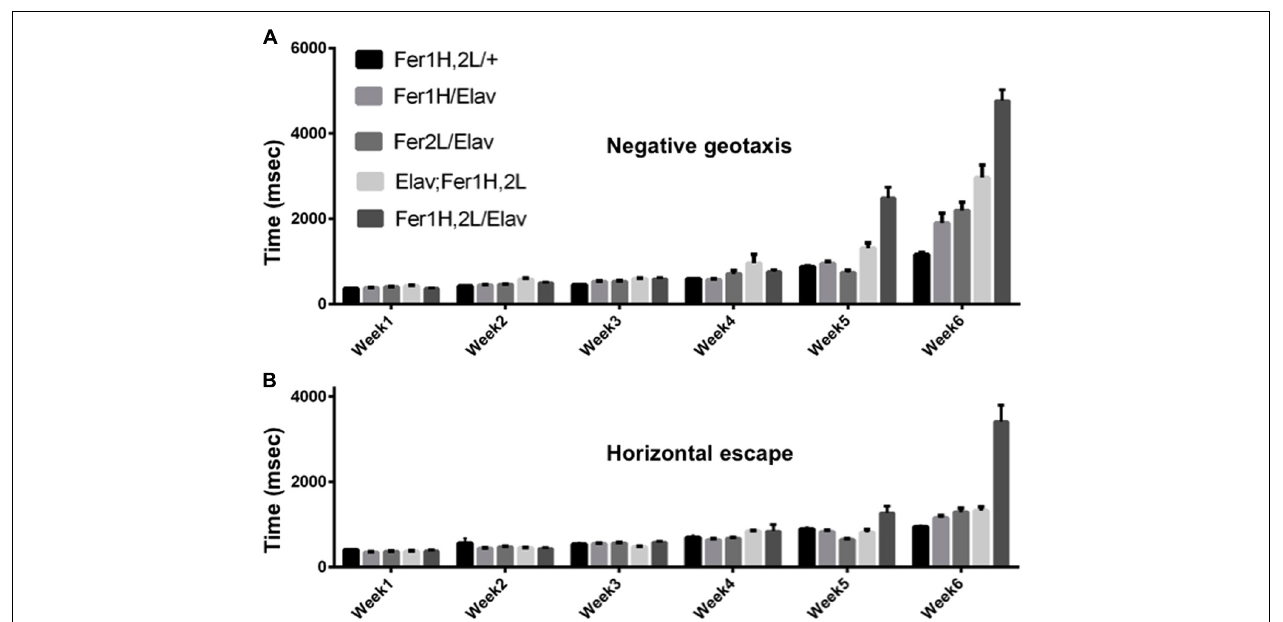
(A) Flies expressing either the heavy or the light chain alone did not exhibit statistical differences from controls in their escape response until the fifth week and showed a moderate twofold increase in their response time on week 6 ( p < 0.05). In contrast, flies overexpressing both ferritin subunits showed a significant impairment at 5 and 6 weeks of age ( p < 0.001). (B) Only flies overexpressing both ferritin subunits from the X-chromosome were significantly compromised when responding in the horizontal direction in weeks 5 and 6 ( p <